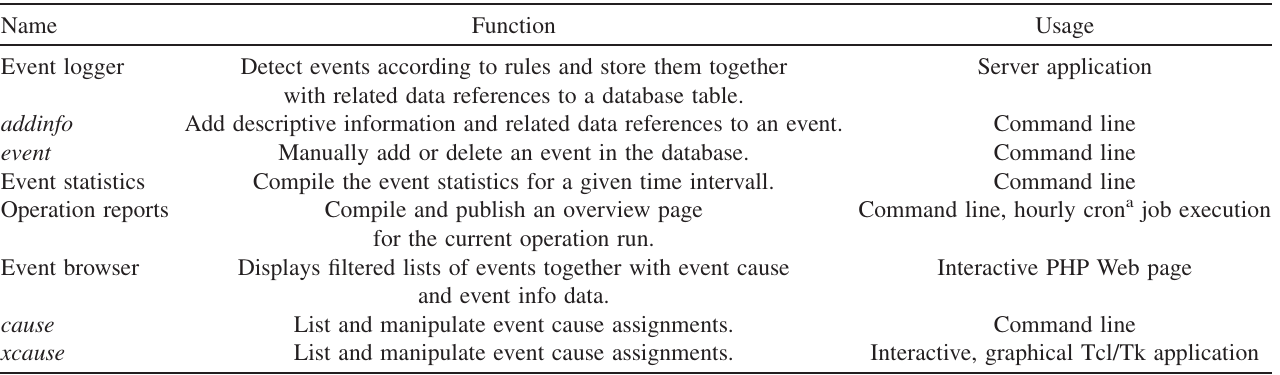
TABLE X. List of applications that access the event